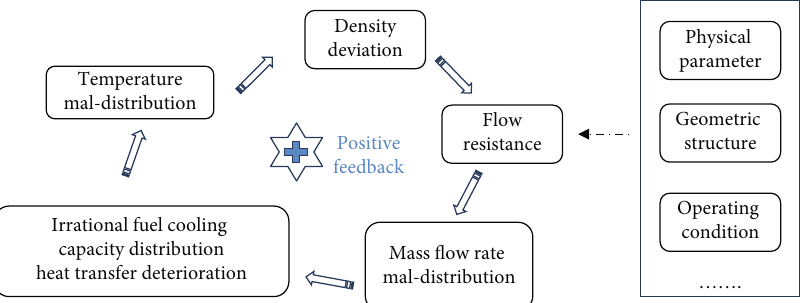
Figure 14: In fl uence mechanism of fl ow distribution in parallel